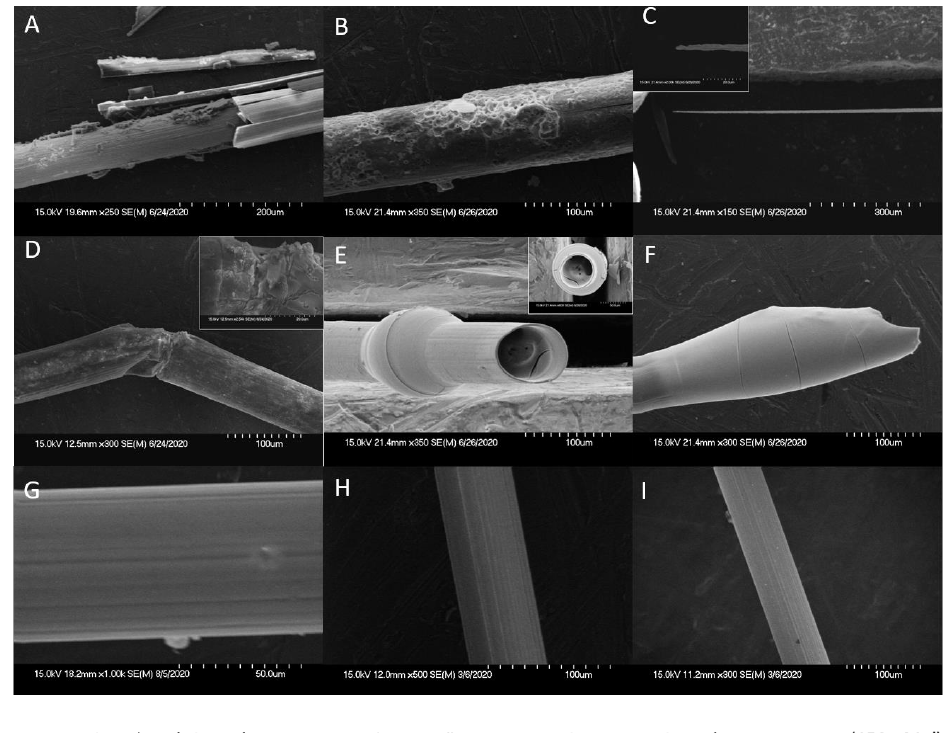
Figure 8. The Weibull cumulative distribution data and corresponding curve fitting of the closed-tip tungsten wires with a single layer coating (1 µm) of PA, Si 3 N 4 , and SiO 2 , tested at 67 °C in different solutions.